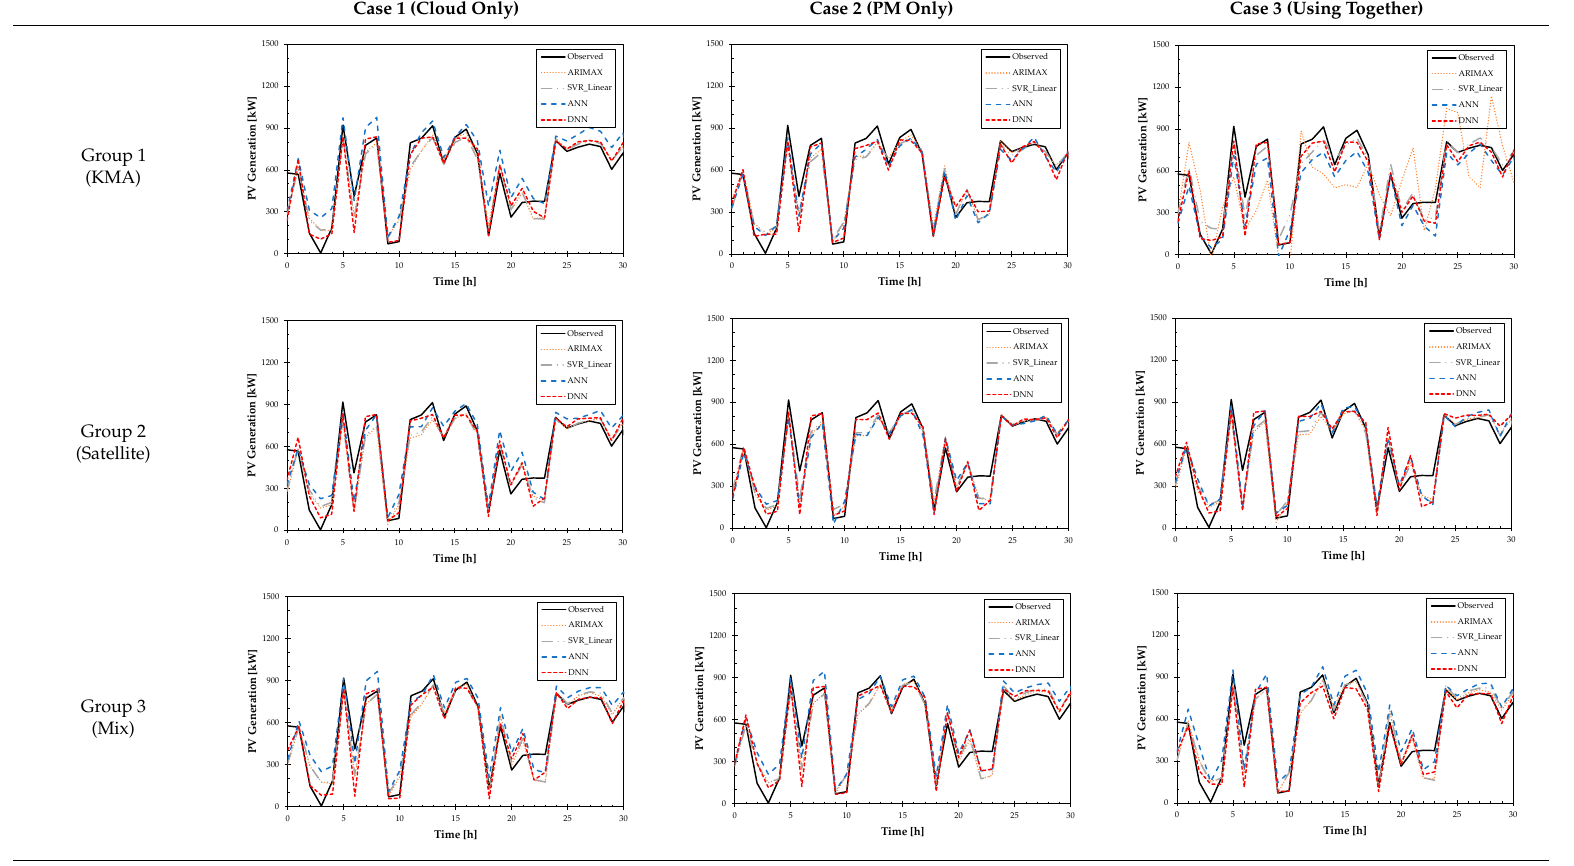
Table 13. Solar PV generation prediction result of each group. Case 1 (Cloud Only) Case 2 (PM Only) Case 3 (Using Together)